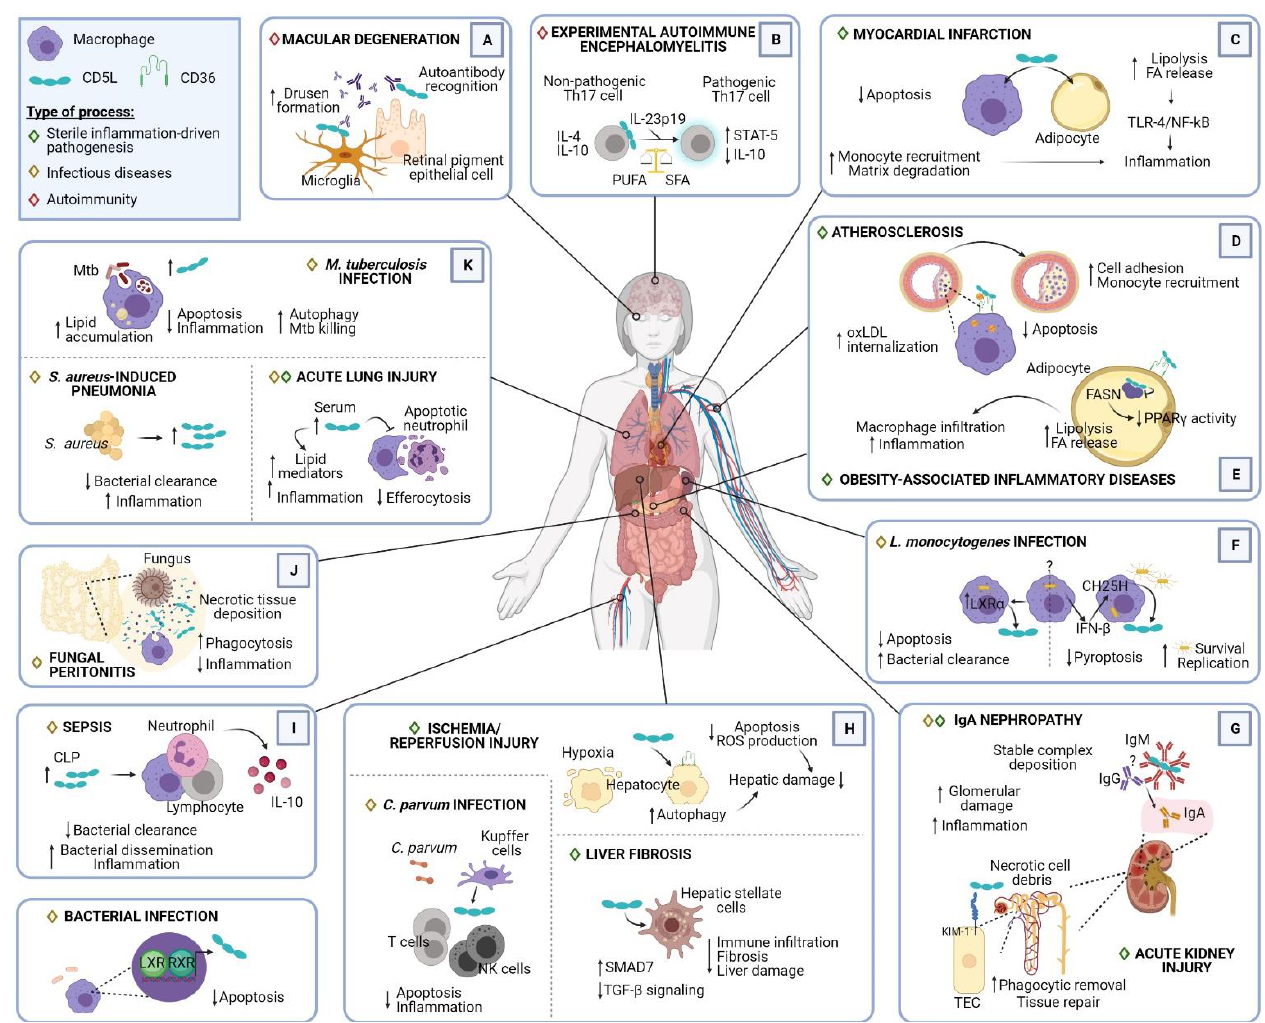
Figure 2. Multiple roles of CD5L in pathogenesis. Representative illustration summarizing the different scenarios in which CD5L plays a role, including its source, target cells, interacting proteins, and main outcomes. The processes have been classified into sterile inflammation-driven pathogenesis, infectious diseases, and autoimmunity, and have been grouped according to the affected region: ( A ) eye; ( B ) brain; ( C ) heart; ( D ) artery; ( E ) adipose tissue; ( F ) spleen; ( G ) kidney; ( H ) liver; ( I ) circulation; ( J ) peritoneum; ( K ) lung. ↓ , decreased; ↑ , increased. Abbreviations: HSC, hepatic stellate cells; TEC, tubular epithelial cells; NK, natural killer cells; ROS, reactive oxygen species, Mtb, M. tuberculosis ; CH25H, cholesterol 25-hydroxylase; FA, fatty acids; FASN, fatty acid synthase; PUFA, polyunsaturated fatty acids; SFA, saturated fatty acids; LXR, liver-X-receptor; RXR, retinoid-X-receptor; CLP, cecal ligation puncture; UPR, unfolded protein response (figure created with Biorender.com).